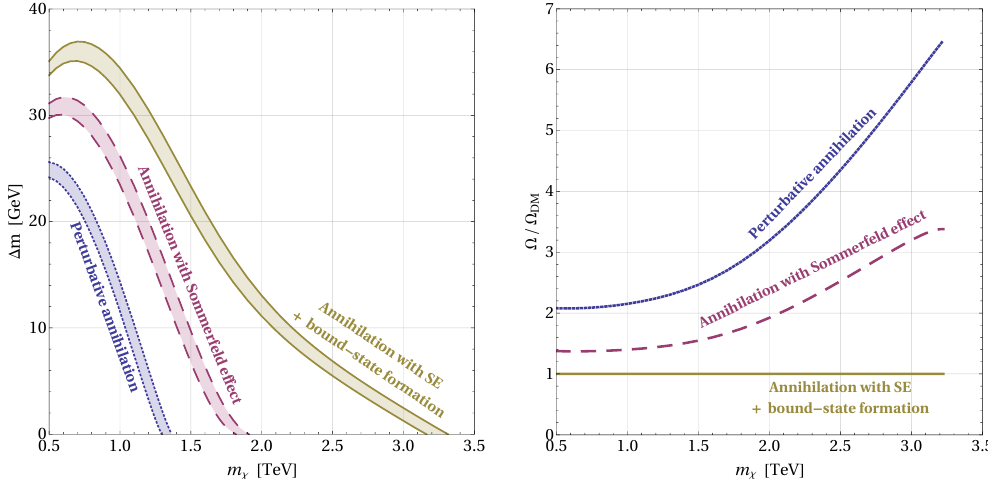
Figure 7. Left panel: the mass splitting (cid:1) m between DM and its coloured co-annihilating partner, that is required to obtain the observed DM density. The blue dotted band takes into account perturbative annihilation only, the purple dashed band incorporates the Sommerfeld e(cid:11)ect on the direct annihilation, and the yellow solid band includes also the e(cid:11)ect of bound-state formation and decay. The width of the bands arises from the 3 (cid:27) uncertainty on the DM density. Right panel: the impact of the Sommerfeld e(cid:11)ect and bound-state formation on the DM density. (cid:1) m is (cid:12)xed with respect to m (cid:31) along the yellow solid band of the left panel. We present the ratios of the relic densities predicted by perturbative annihilation only (blue dotted line) and by Sommerfeld- enhanced annihilation (purple dashed line), to the relic density predicted by the full computation that includes the e(cid:11)ect of bound